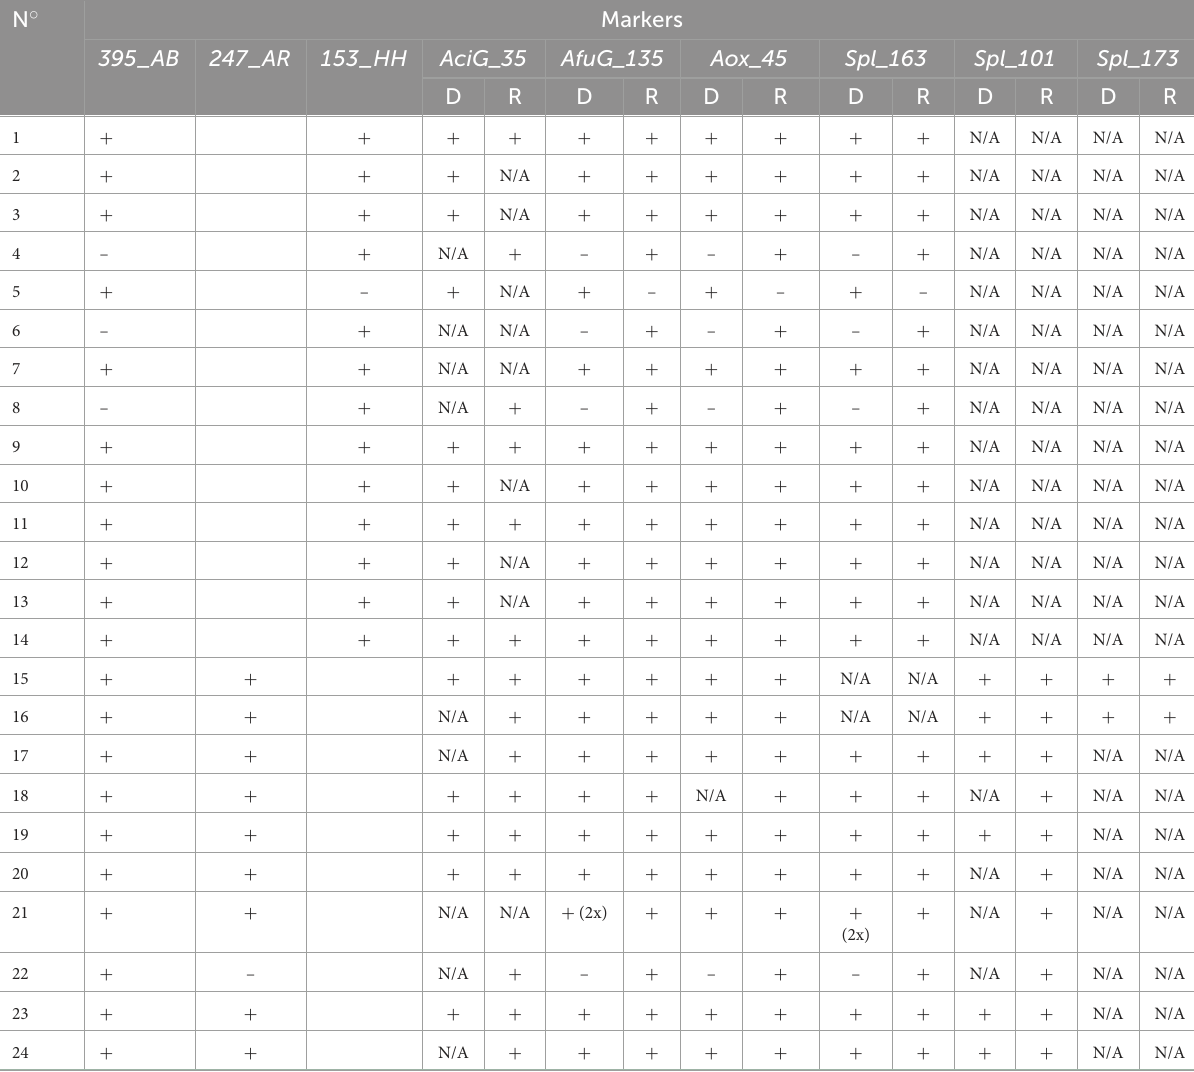
TABLE 3 Molecular analysis with microsatellite markers after different ICSI experiments using fresh-stripped spermatozoa. N ◦ Markers